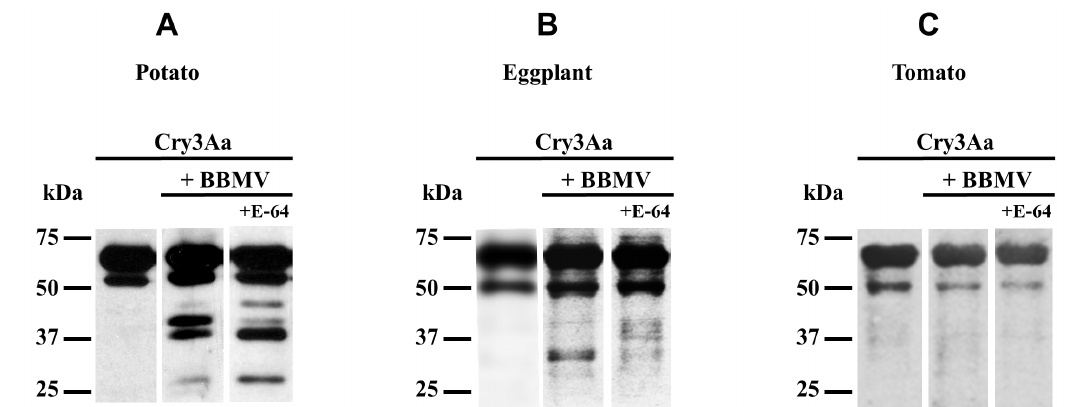
Figure 1. Polypeptide profile of Cry3Aa toxin cleaved by CPB BBMV midgut proteases. All panels show Western blots of Cry3Aa toxin incubated with CPB BBMV in the absence or presence of the cysteine protease inhibitor E-64, and immunodetected with an anti-Cry3Aa toxin polyclonal antibody. ( A ) BBMV from potato-fed CPB larvae; ( B ) BBMV from eggplant-fed CPB larvae; ( C ) BBMV from tomato-fed CPB larvae. In each panel, molecular weight markers are shown on the left of each